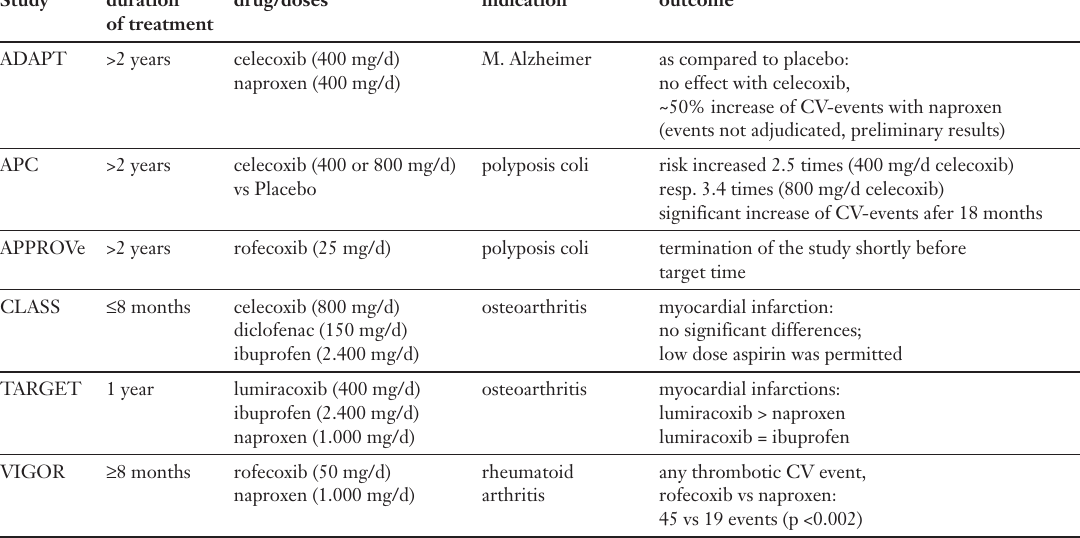
Effect of selective and non-selective inhibitors of cyclo- oxygenase-2 on cardiovascular (CV) events in long-term trials (modified from: Medscape